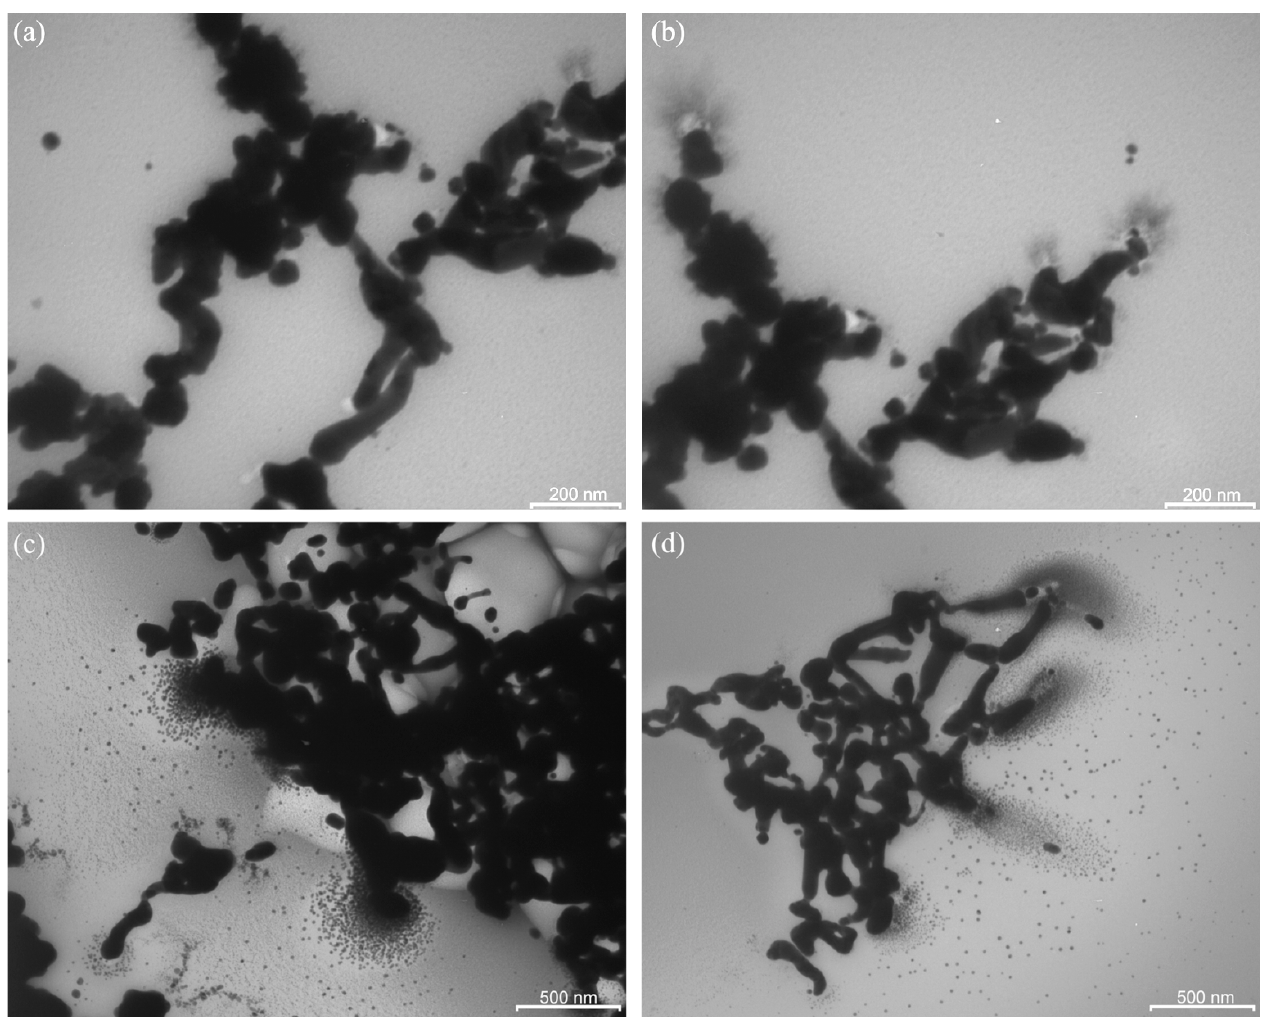
Figure 5. TEM images of the strongly coupled metallic nanostructures in one-year-stored PAAg; images ( a – d ) belong to the same sample in different scales or magnification of the image in different areas.